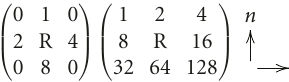
Figure 1: Binary scaled N 4 and N 8 neighborhood coe ffi cients k ( i , j ).